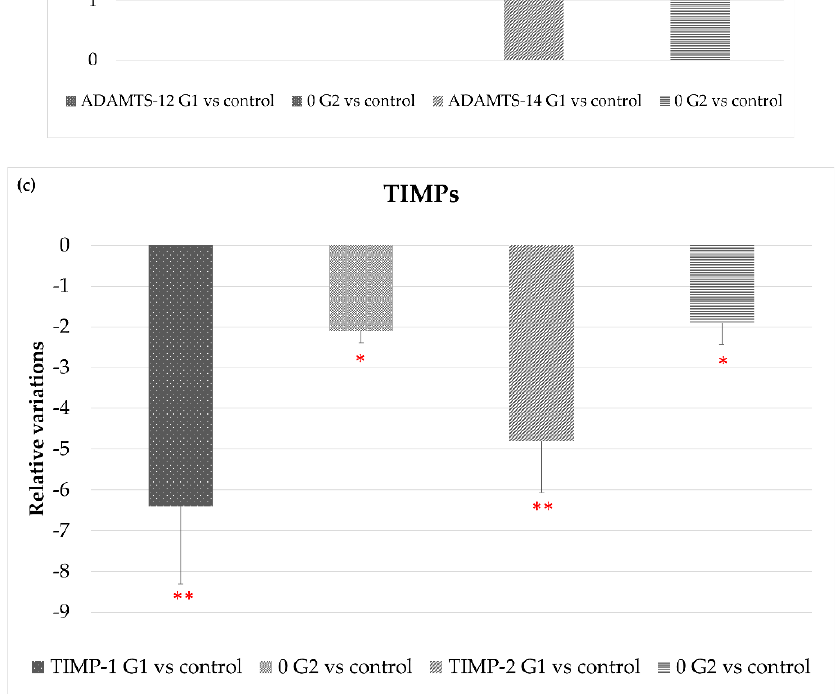
Figure 4. Variations in gene expression in both, experimental vs. control groups of ( a ) MMP2 and MMP9; ( b ) ADAMTS- 12 and ADMSTS-14; and ( c ) TIMP1 and TIMP-2, * p < 0.05; ** p <